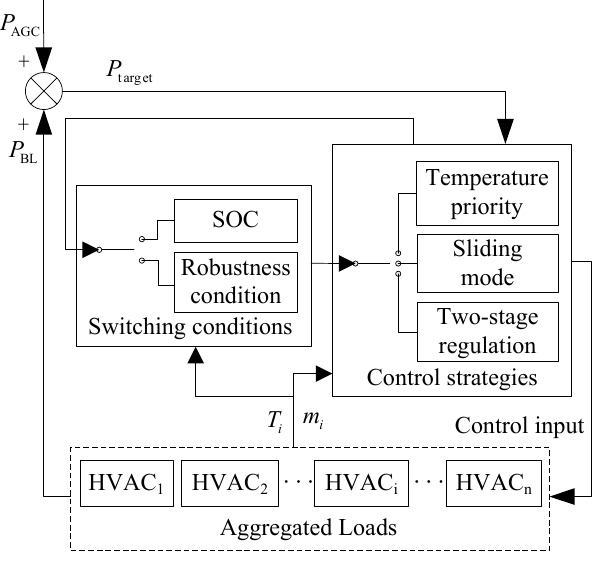
Figure 3. Diagram of the switched control